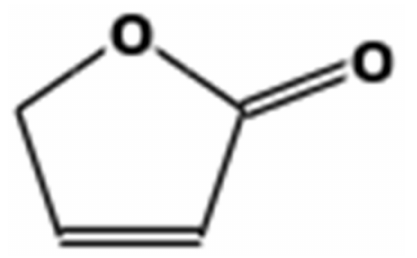
Figure 8. Chemical structure of 2(5 H